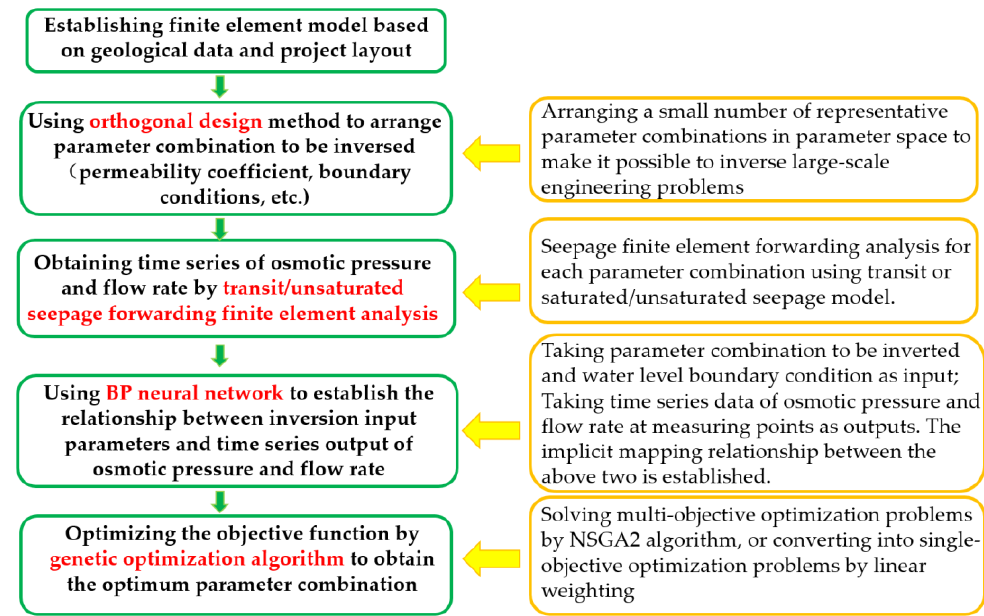
Figure 13. Flowchart for multi-objective, full process dynamic inverse analysis [68–70].